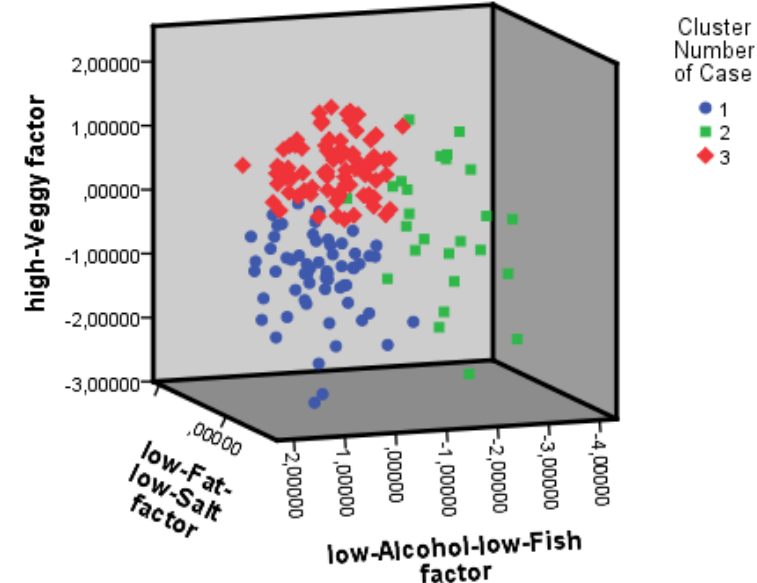
Figure 1. Individuals clustered based on scores on nutritional components. This figure illustrates the three clusters and their scores on the nutritional components (PCA factors). Nutritional components are represented by the axes of the figures. Cluster 1: blue; Cluster 2: green; Cluster 3: red.